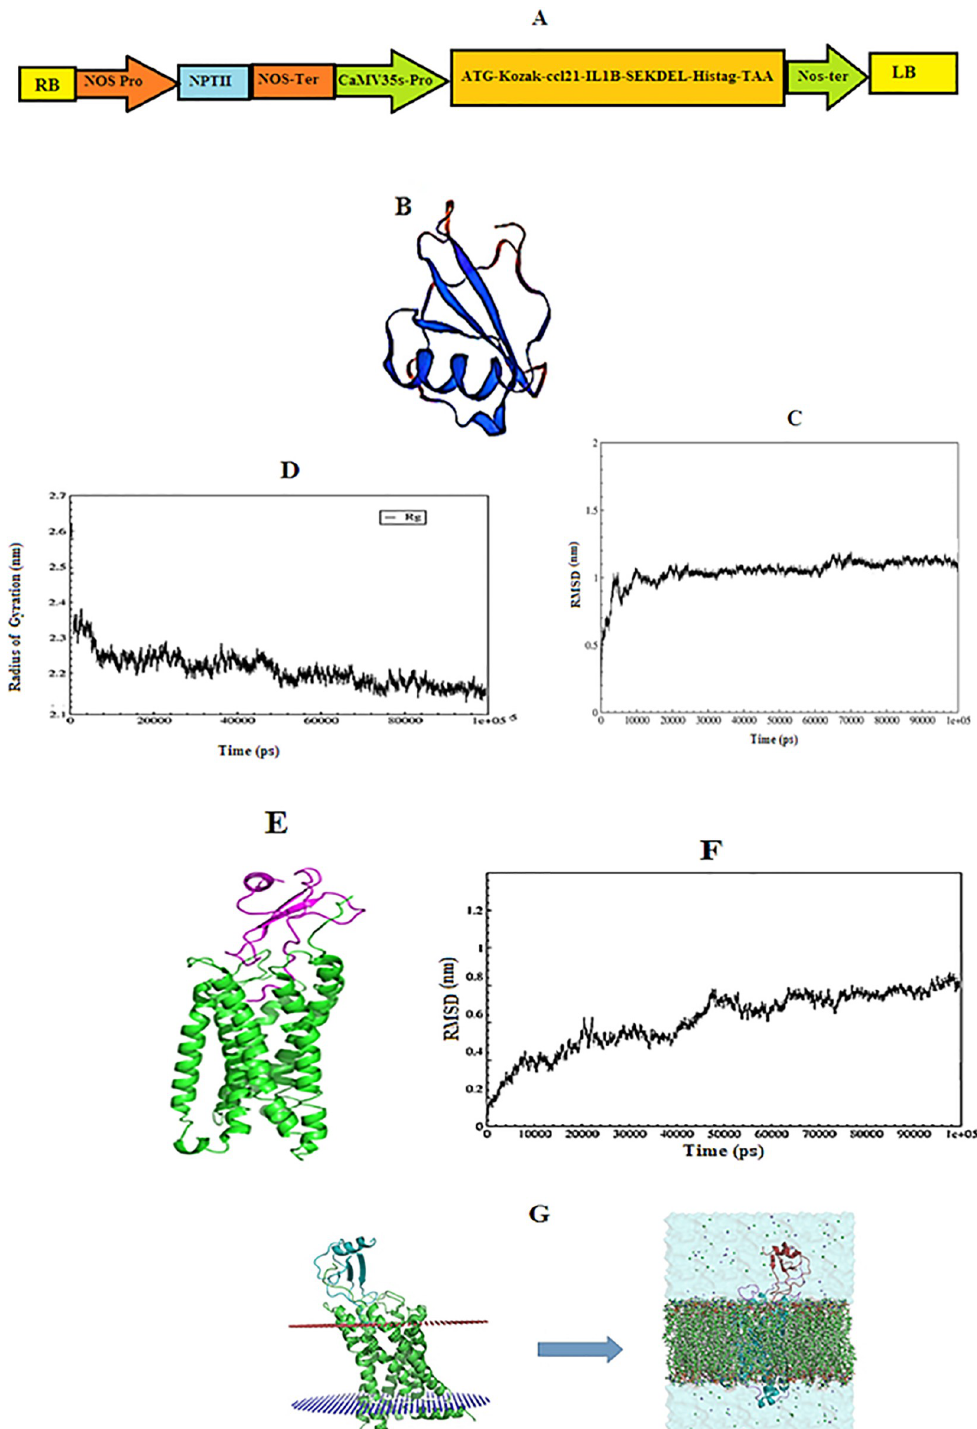
Fig 1. In silico analysis of the recombinant protein. A : Schematic representation of the pBI121- ccl21/IL1 β construct. B : The best model for the recombinant protein as designed by Modeler 9.24. C : RMSD values in MD simulation of the recombinant protein: RMSD slope increased rapidly in the first 10 ns of MD simulation. RMSD reached 1 nm after about 10 ns, and 1.25 nm at 60 ns. Afterward, RMSD decreased slightly, reached 1.1 nm at 70 ns, and remained constant until the end of simulation. D : RG values in MD simulation of the recombinant protein: protein’s RG was about 2.3 nm, but it